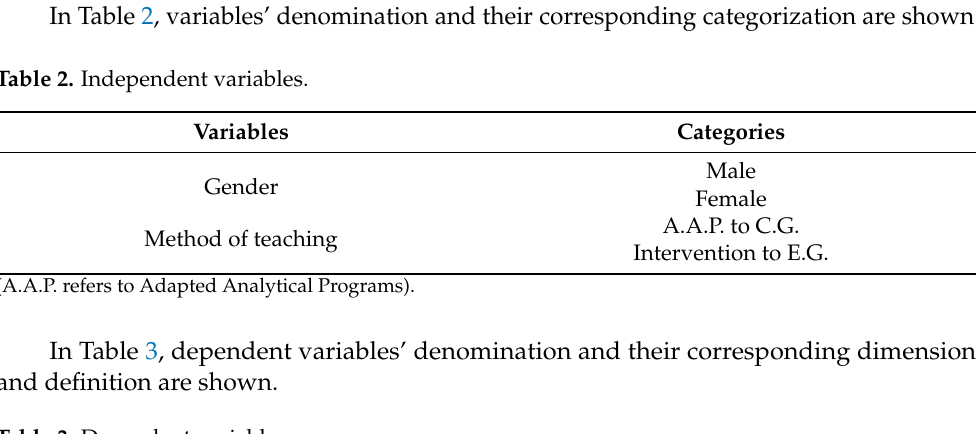
Table 3. Dependent